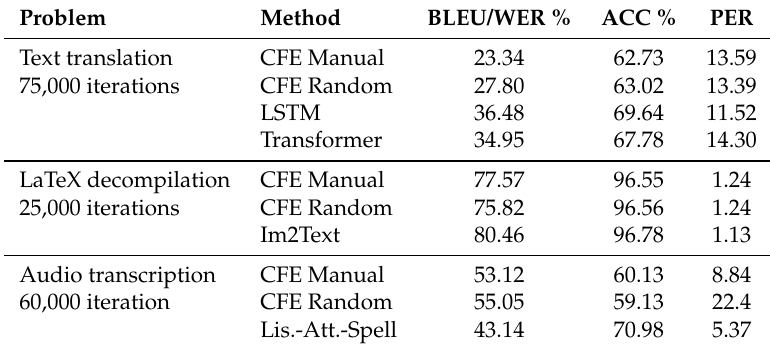
Table 2. Experimental results for the proposed CFE model and other architectures. BLEU/WER: accuracy measures for the test set, bilingual evaluation understudy (text translation and LaTeX decompilation) and word error rate (audio transcription), respectively; ACC and PER: accuracy and perplexity obtained for the validation set, respectively. The total number of iterations applied for each problem in the training process is